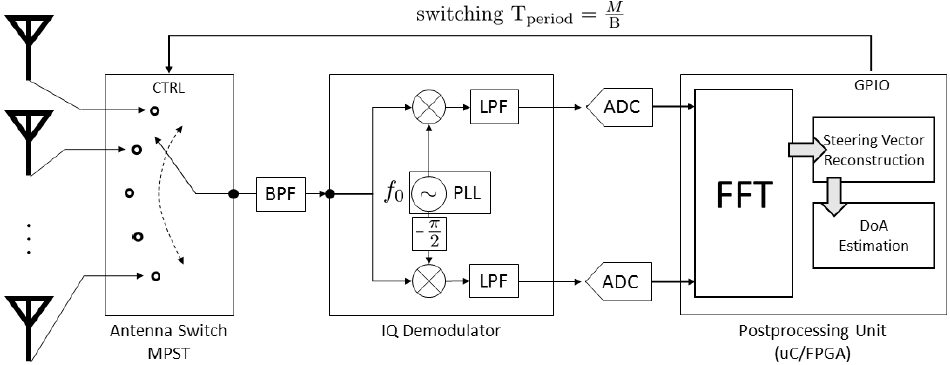
Figure 4. Scheme of an IQ demodulator switched beam array-based receiver